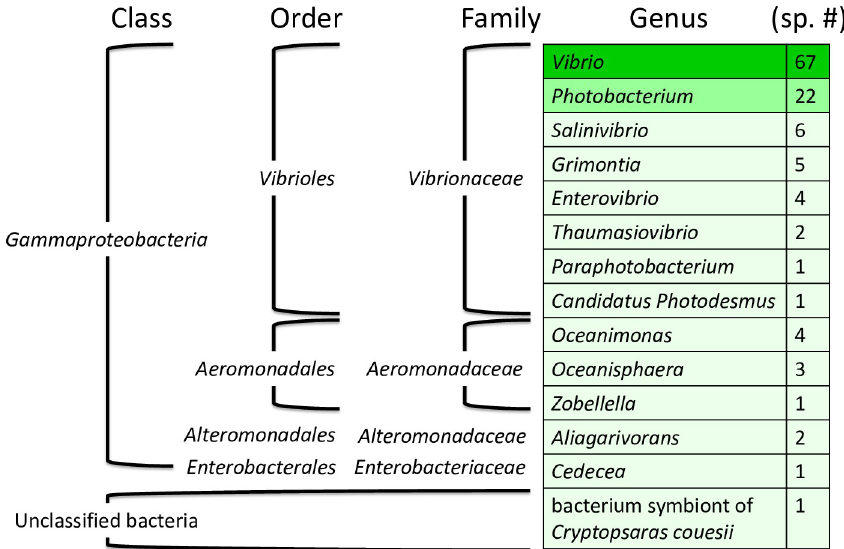
Fig 4. Distribution of the bacterial species harboring a polyhydroxybutyrate (PHB) synthesis gene cluster ( phaB - phaA - PFP - phaC )similar to that of the Zobellella denitrificans ZD1. Genus name and the family, order, and class ranks are indicated accordingly. Sp # refers to the number of bacterial species containing the PHB synthesis gene cluster. Only one strain per species was used in the calculation. See "Materials and Methods" for